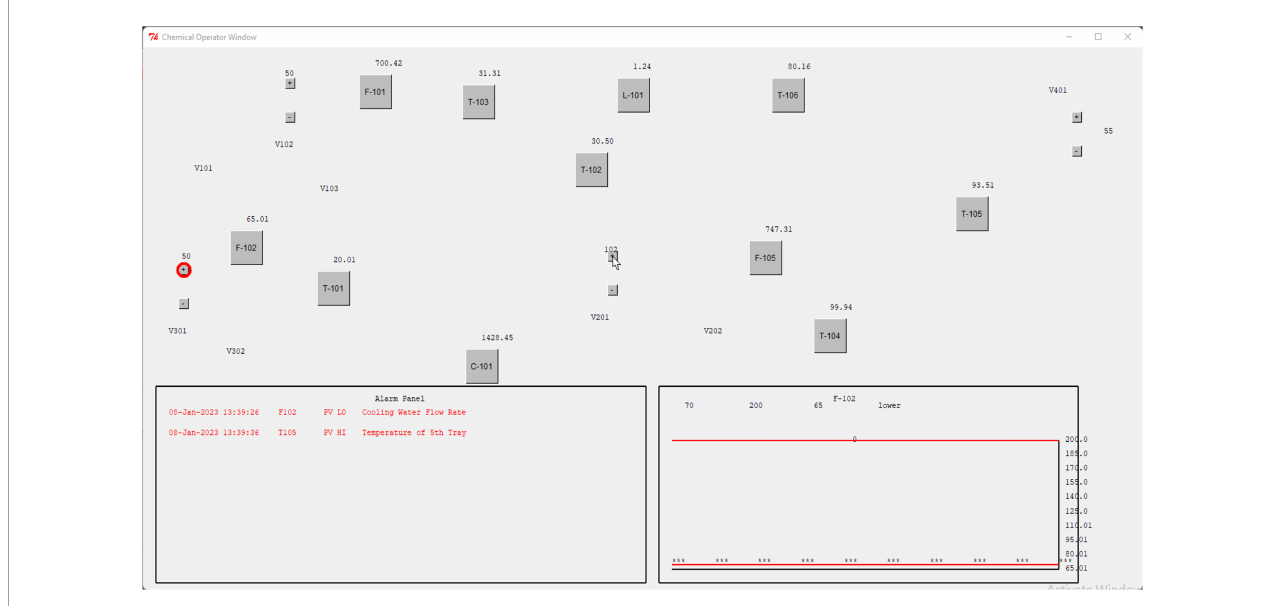
FIGURE4 Human machine interface of the process simulator used by the